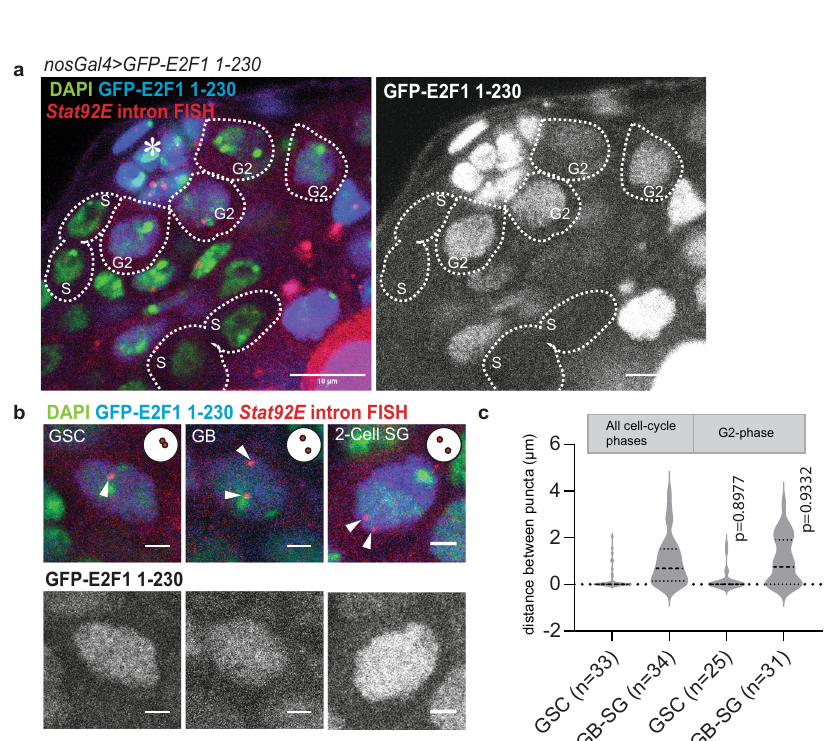
Fig. 3 The change in Stat92E pairing states does not re fl ect the difference in cell-cycle stages. a A representative image of Stat92E nascent transcript (red) in Fly-Fucci testis. GFP-E2F1-230 (blue) is positive in G2-phase and negative in S-phase cells. White dotted lines encircle germ cells in indicated cell cycle stages. DAPI is shown in green. Right panel shows GFP channel. Stat92E nascent transcript was typically weak or undetectable in S-phase cells. b Representative images of G2 phase germ cells in indicated stages. Stat92E intron FISH signal (white arrowheads) indicate pairing states at the indicated stage of germ cells. Representative pairing states are shown in the upper right corner of each image. Lower panels show GFP channel. c Violin plots show distances between Stat92E nascent transcript puncta at the indicated stages of germ cell development measured in all cell-cycle stages or only in G2-phase cells. Violin plots show KDE and quantile lines and the width of each curve corresponds with the frequency of data points. The adjusted p values were calculated with Š idák ’ s multiple comparisons. All plotted data points are provided in Source Data. Number of scored cells, which are randomly chosen from at least 10 testes for each experiments, is shown for each data point. Scale bars in ( a ) represent 10 μ m. Scale bars in b represent 2 μ